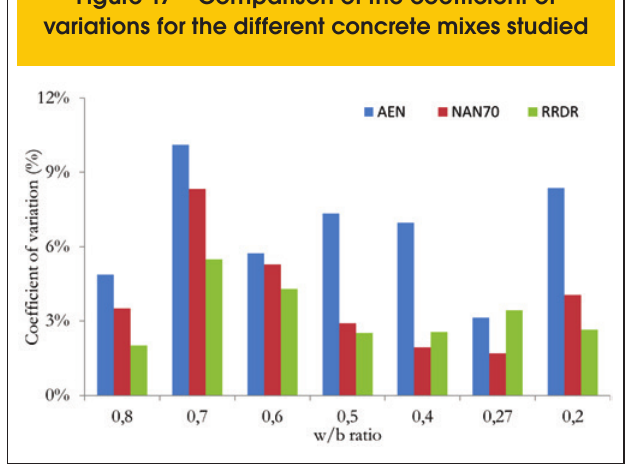
Figure 17 – Comparison of the coefficient of variations for the different concrete mixes